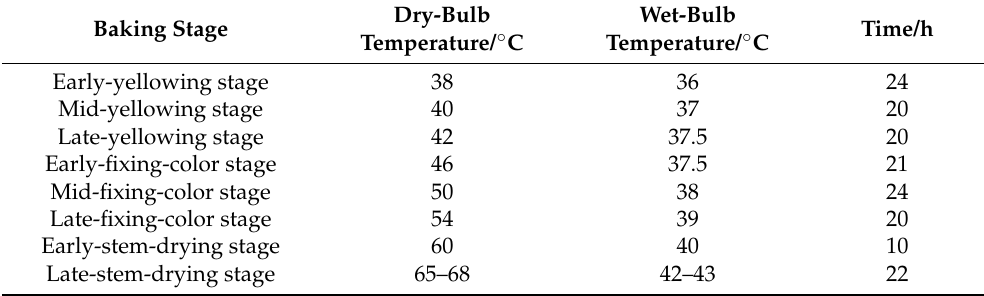
Table 2. Parameters of the baking process.